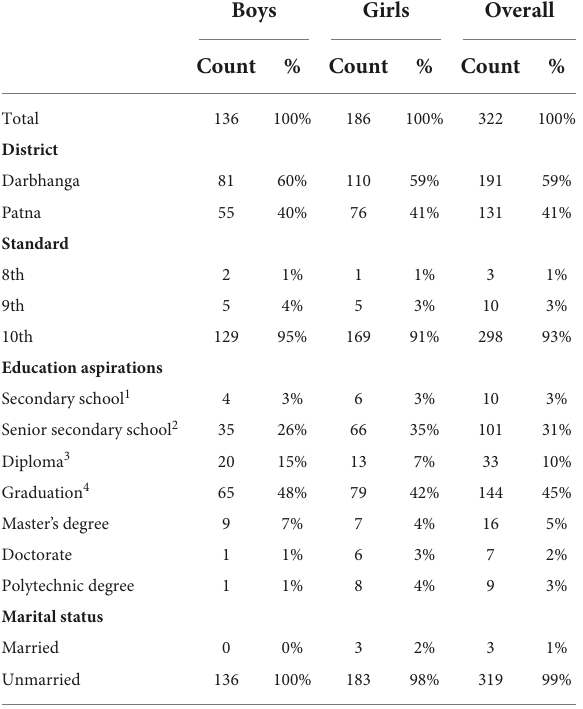
TABLE 3 Demographic profile of the